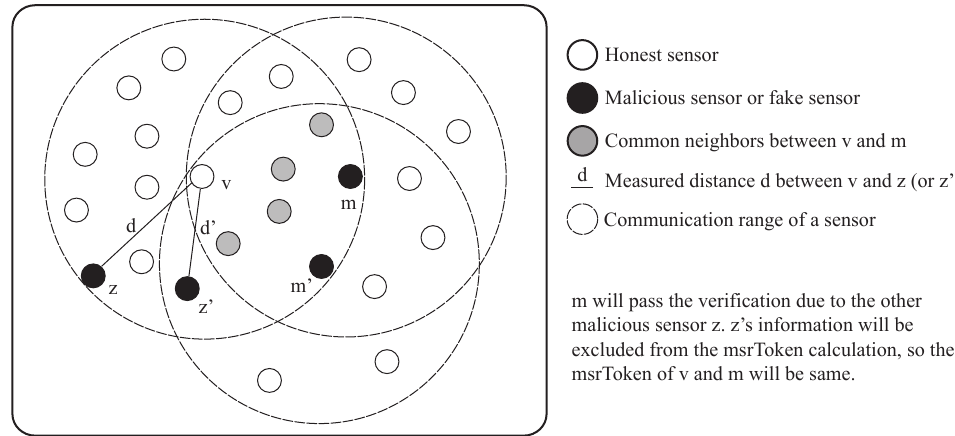
Figure 16. The side-effect of the distance-inconsistency